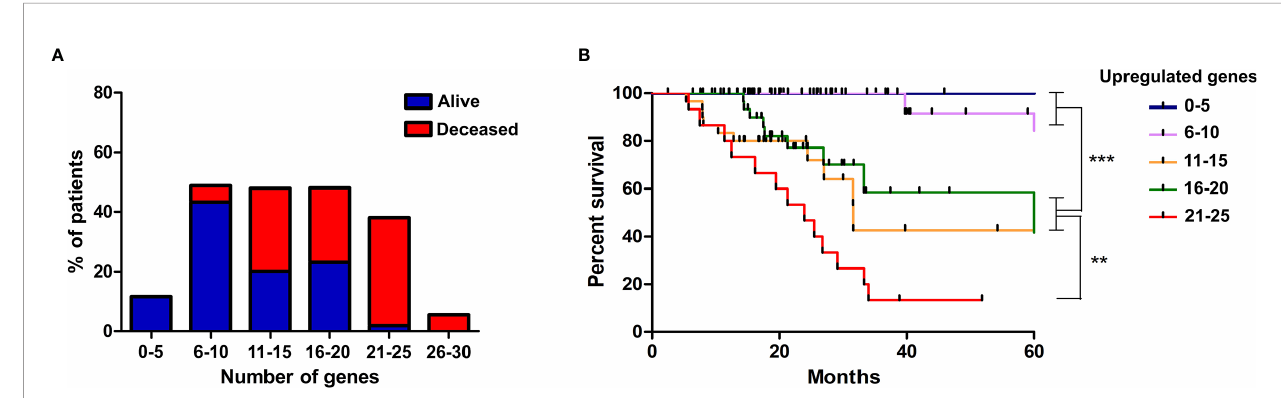
FIGURE 6 | The progressive accumulation of up-regulated ECM-receptor interaction genes impacts the resistance of tumors to irradiation. (A) The number of genes with expression above the threshold de fi ned by the ROC curve was evaluated in each patient submitted to IR treatment and six categories, with an increasing number of altered genes, were de fi ned. The percentage of alive or deceased patients included in each category is indicated. (B) Kaplan Meier survival curves for LGG patients according to the categories described in (A) . Graphs were plotted with GraphPad Prism